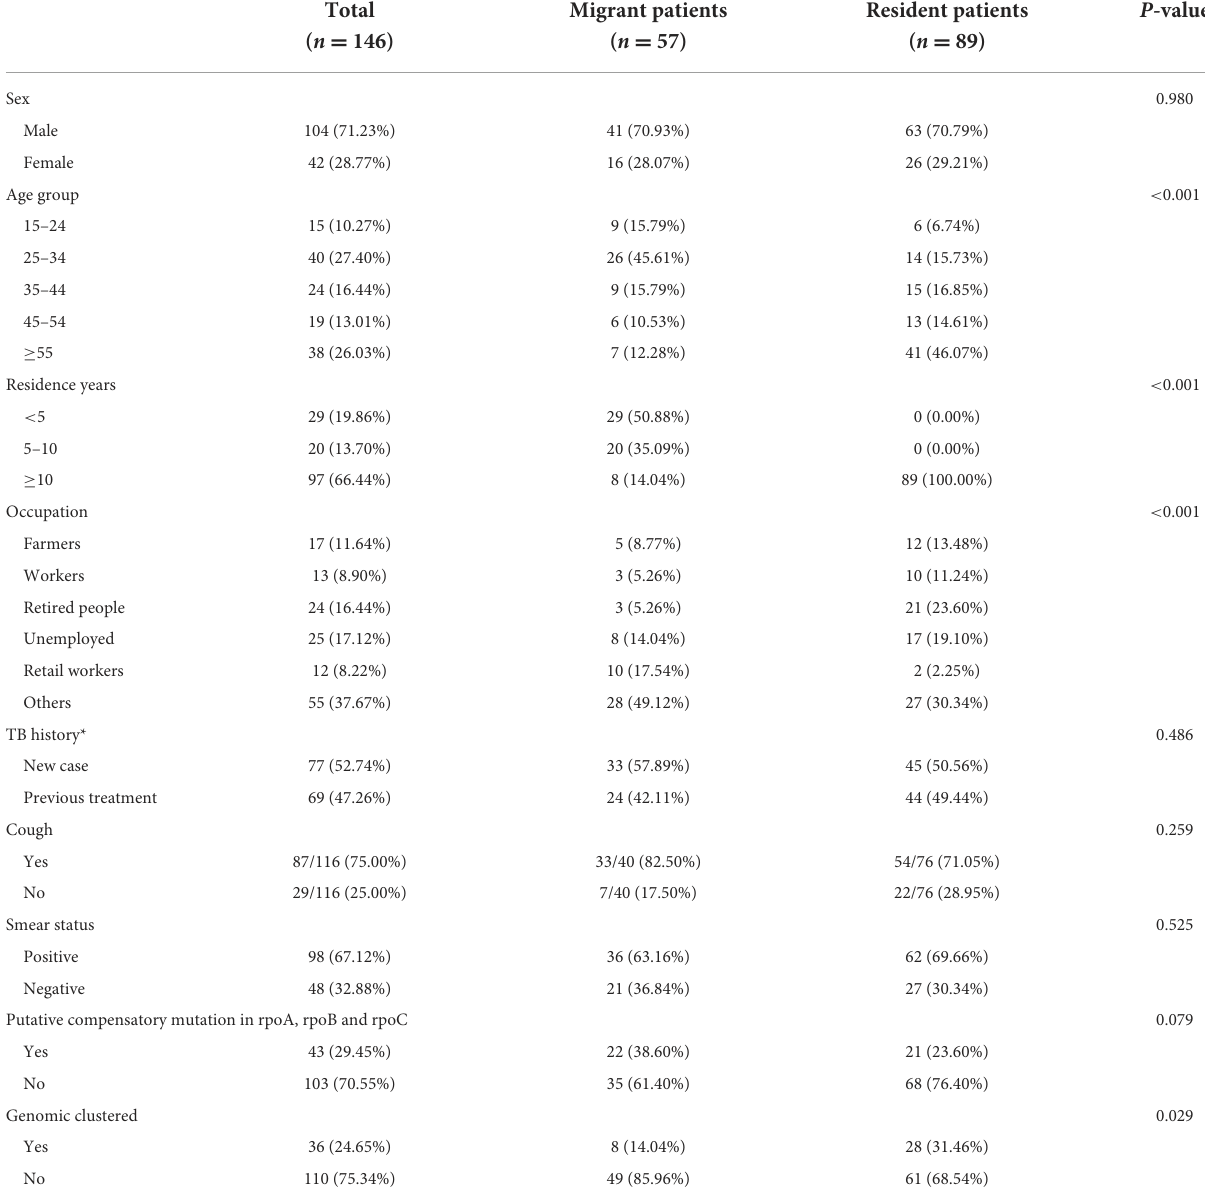
TABLE 1 Demographic, clinical, and bacteriological characteristics of internal migrant patients and resident patients diagnosed in